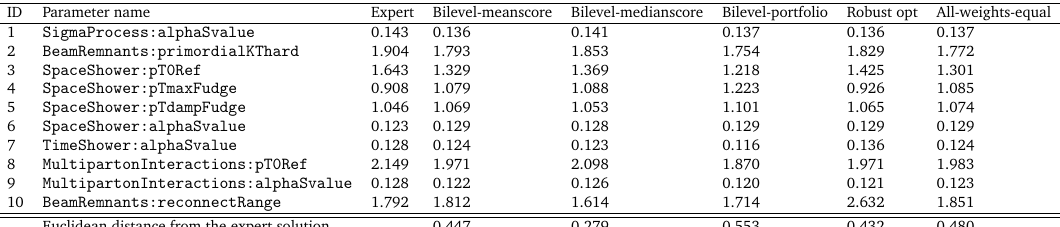
Table 24: Optimal parameter values for A14 when using the cubic polynomial approx- imation with all methods after outlier detection to filter out observables that cannot be approximated well by the